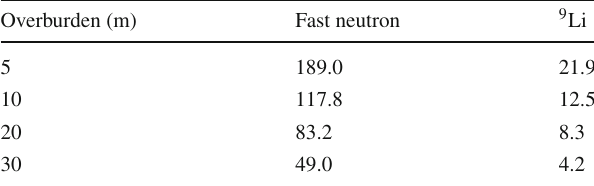
Table1 Thetotalratesperdayforfastneutroninducedand 9 Liinduced backgrounds for each Daya Bay detector with different overburdens [71]. Here the event rates are obtained with the neutrino energy in the